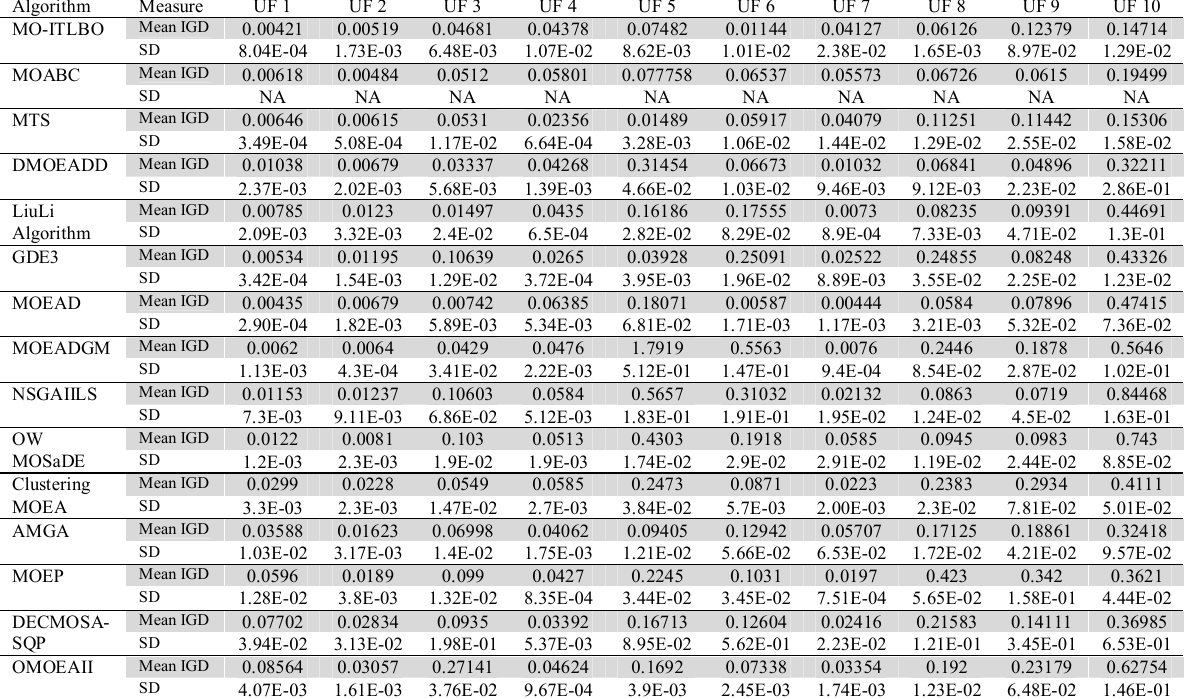
Comparison of mean IGD values and the standard deviation (SD) obtained with different algorithms for different unconstrained test functions (UF1-UF10) in 30 independent